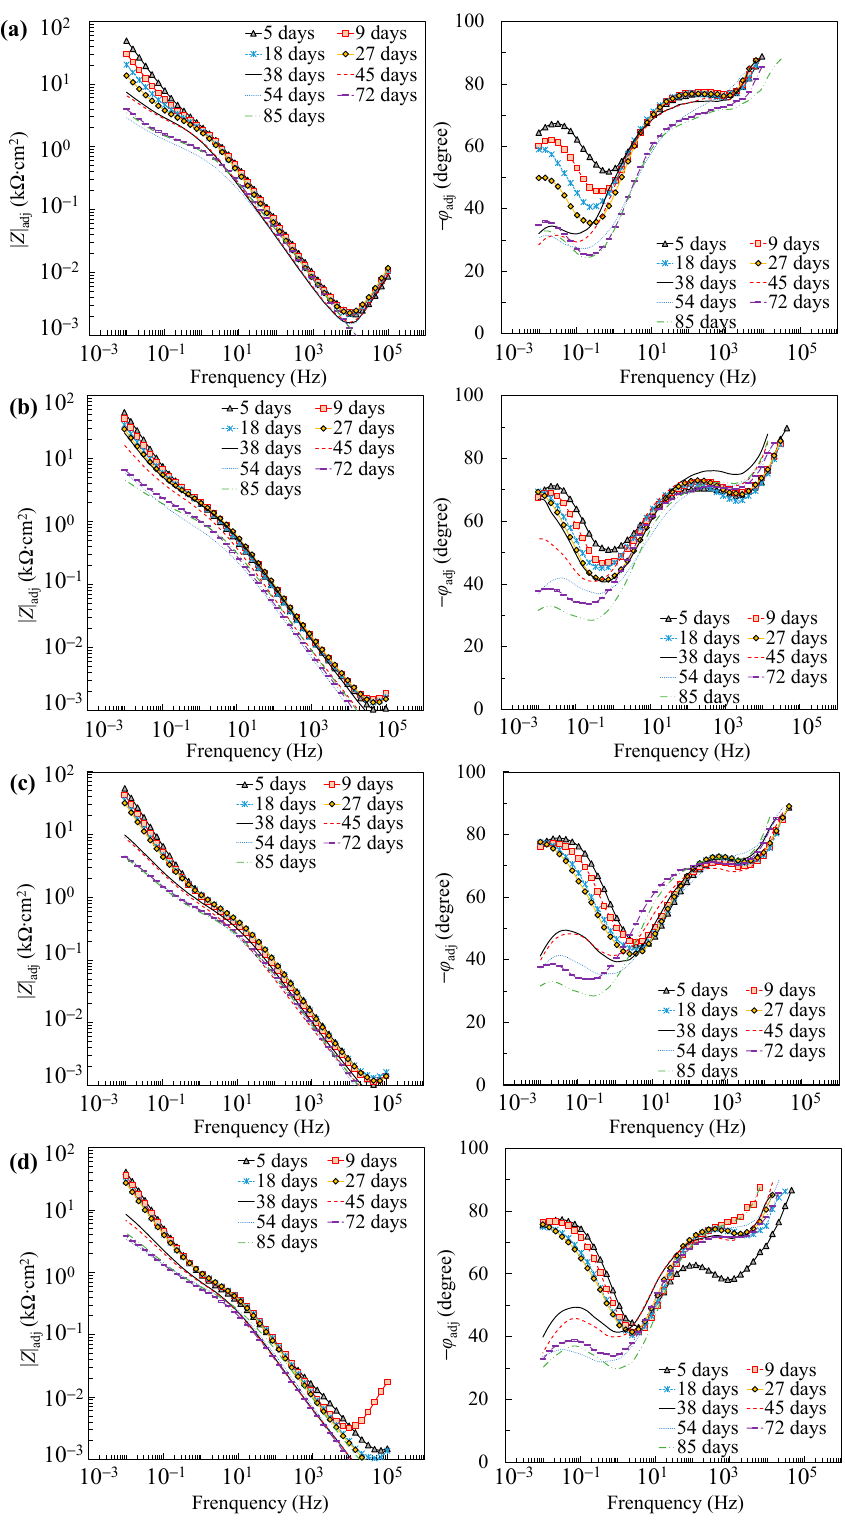
Figure 3. Adjusted Bode plots of individual specimens: ( a ) A0; ( b ) A3; ( c ) A5; ( d ) A10.